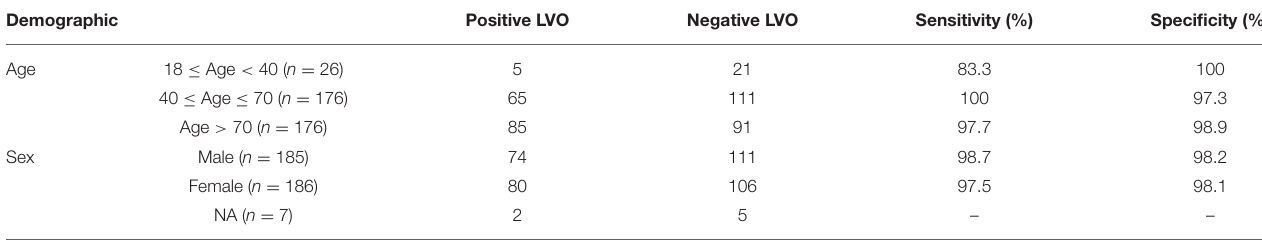
TABLE 7 | Performance metrics for LVO cases among different demographic parameters. Demographic